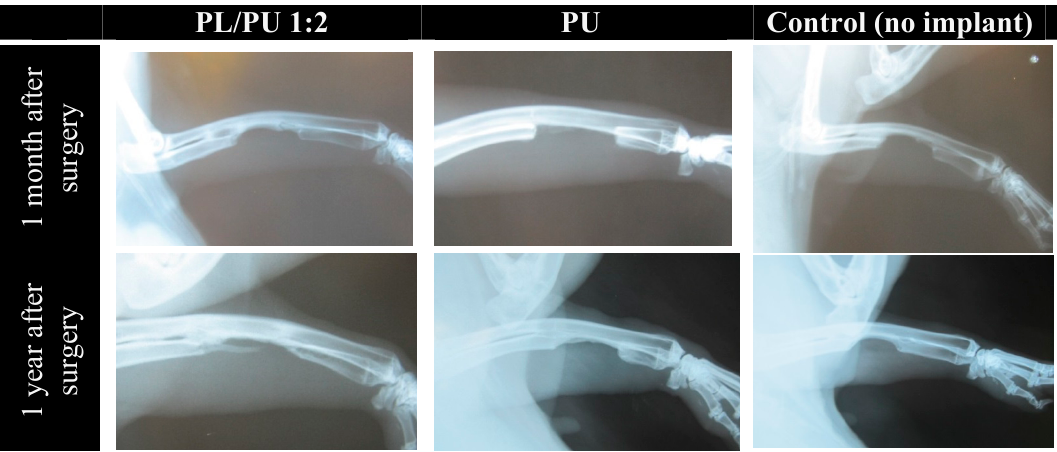
Figure 12. Healing process of critical-sized bone defect in NZW rabbit model with different implants.